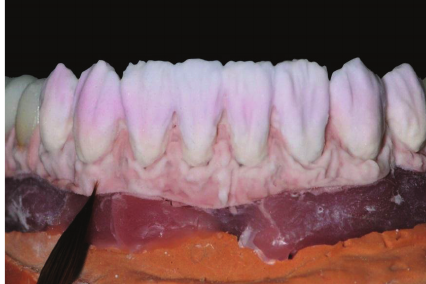
Figure 10: Intraoral lateral view of the final prostheses.